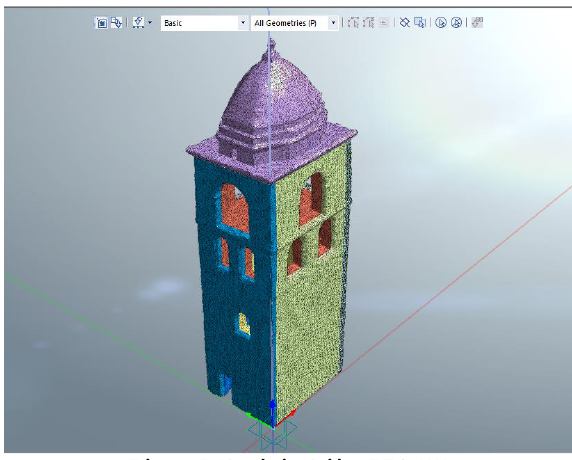
Figure 5. Mesh in Midas FEA NX